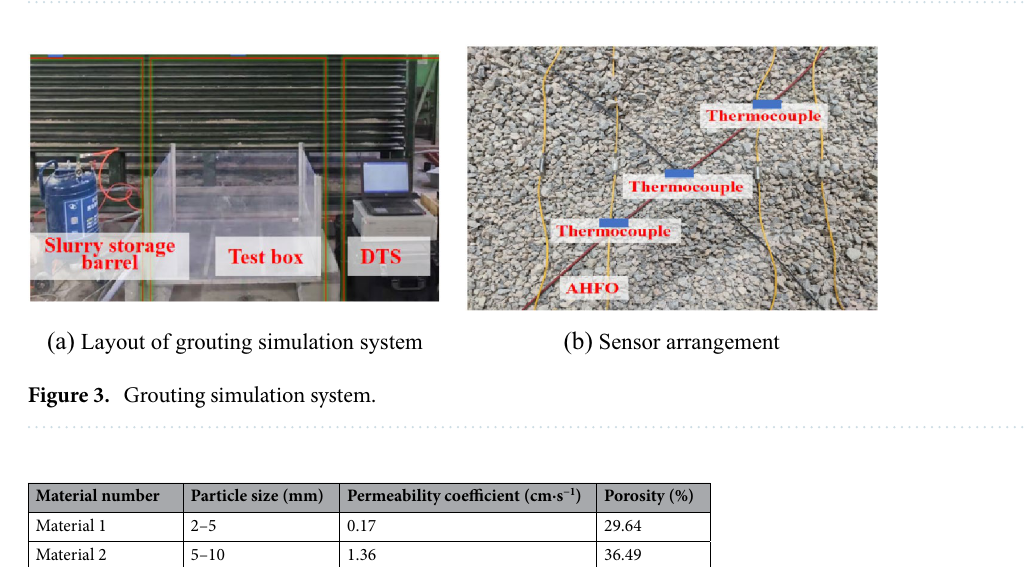
Figure 2. Temperature measurement results.